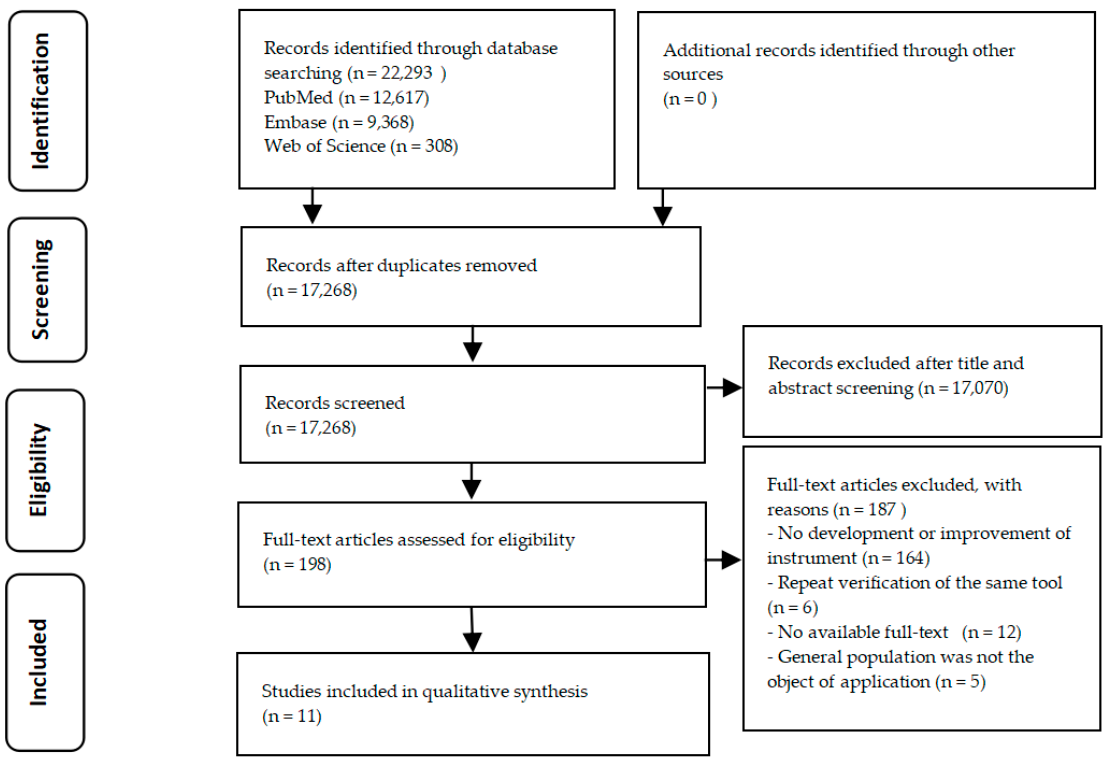
Figure 1. Preferred Reporting Items for Systematic Reviews and Meta-Analysis (PRISMA) flow diagram of literature selection. n: number of articles.